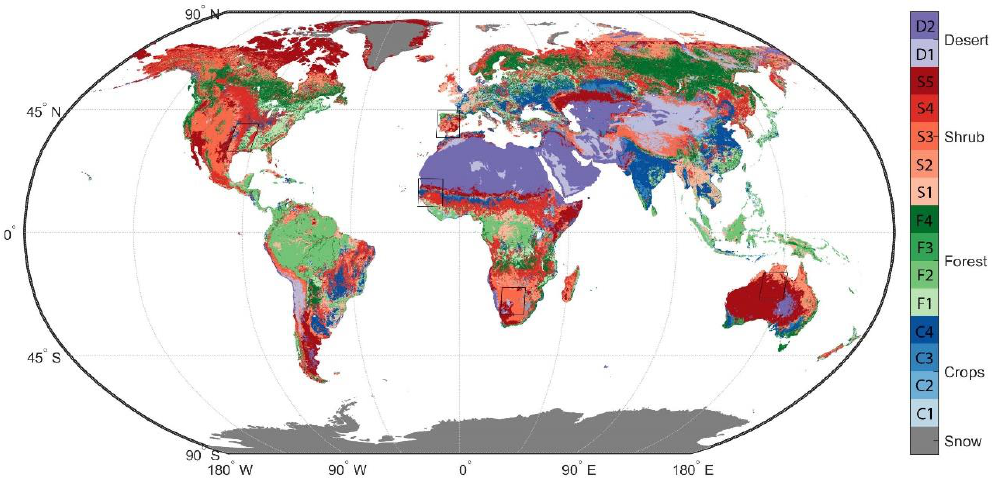
Figure 1. Spatial distribution of the cluster-based surface classification. The rectangles indicate the areas used in the model evaluation with the GT_MDB.